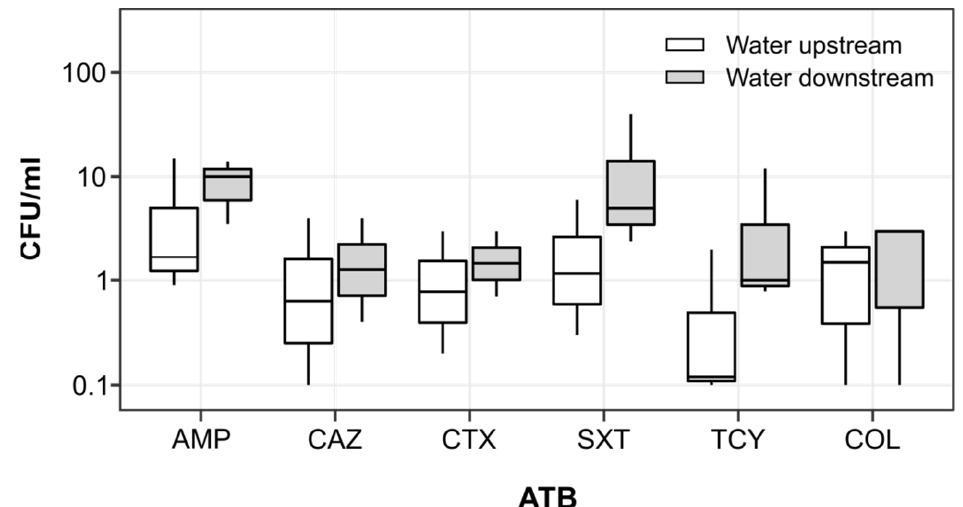
Figure 9. Box plots of the abundance of culturable Escherichia coli resistant to ampicillin (AMP), ceftazidime (CAZ), cefotaxime (CTX), sulfamethoxazole (SXT), tetracycline (TCY), and colistin (COL) measured in the river